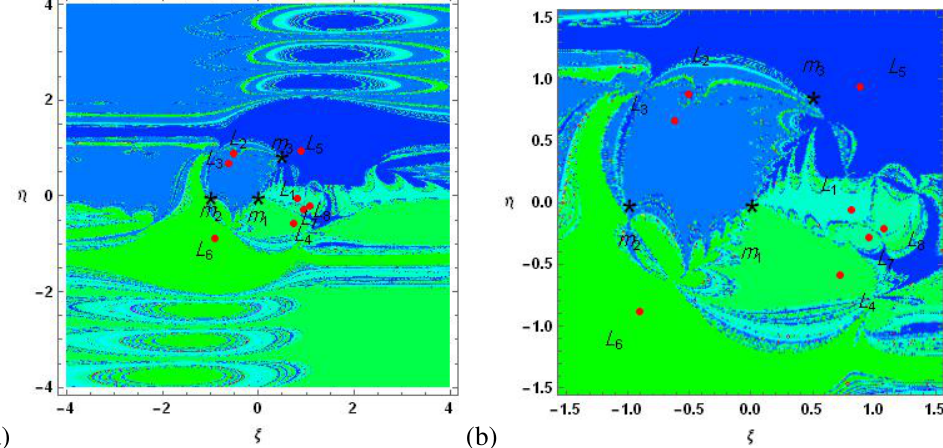
Fig. 9 (a): The basin of attraction for the Albedo case. (b): Zoomed image of (a) near the lagrangian configuration.